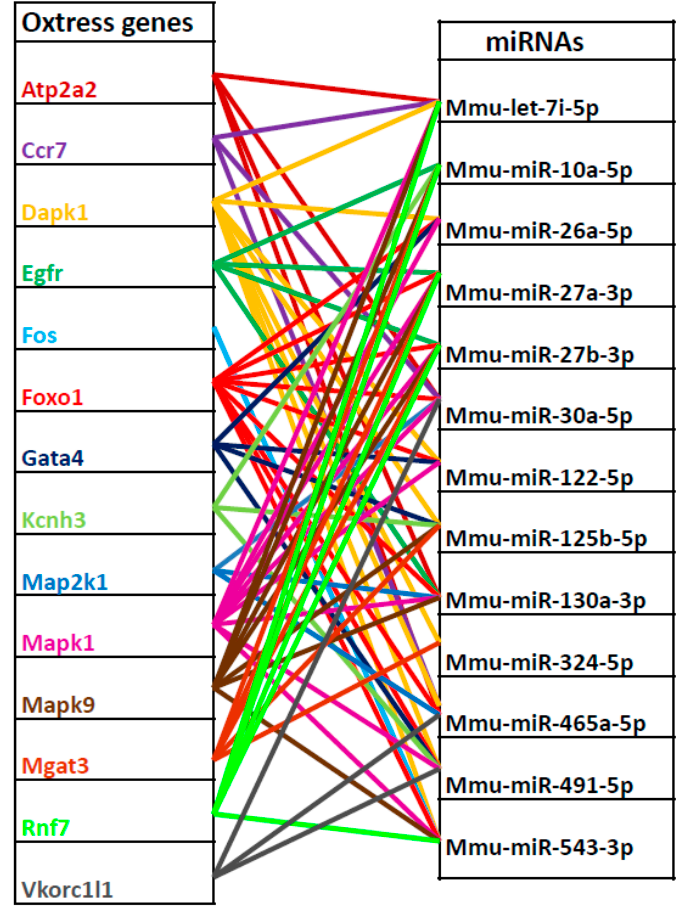
Figure 2. Predicted functional relationships among the 14 validated Oxstress genes and the 13 miRNAs upregulated during ATHp. Shown are, on the left the 14 validated Oxstress genes and on the right the 13 miRNAs upregulated during ATHp. Lines linking both columns indicate Oxstress transcripts that are predicted targets of the corresponding miRNAs. Data obtained from Table 2. Table 2. Predicted miRNAs targeting each one of the 14 validated Oxstress transcripts. For each one of the validated Oxstress genes (identified by their gene symbol), shown are the predicted miRNAs targeting their 3’UTRs. Analysis was performed at the miRSystem browser (see Materials and Methods). In bold, miRNAs predicted to target both Ccr7 and Foxo1